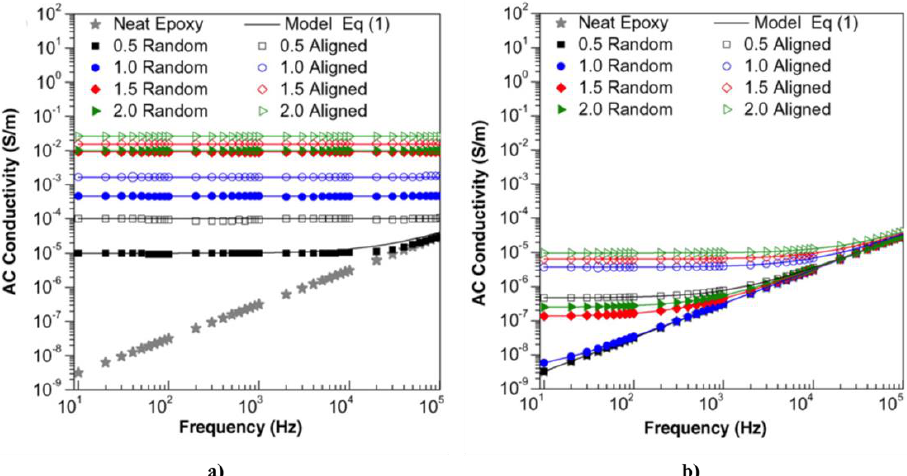
Figure 42. AC conductivity of epoxy nanocomposites as a function of frequency: ( a ) CNFs/epoxy nanocomposites and ( b ) GNPs/epoxy nanocomposites for various particles. Reprinted from [114], Copyright 2016, with permission from Elsevier.